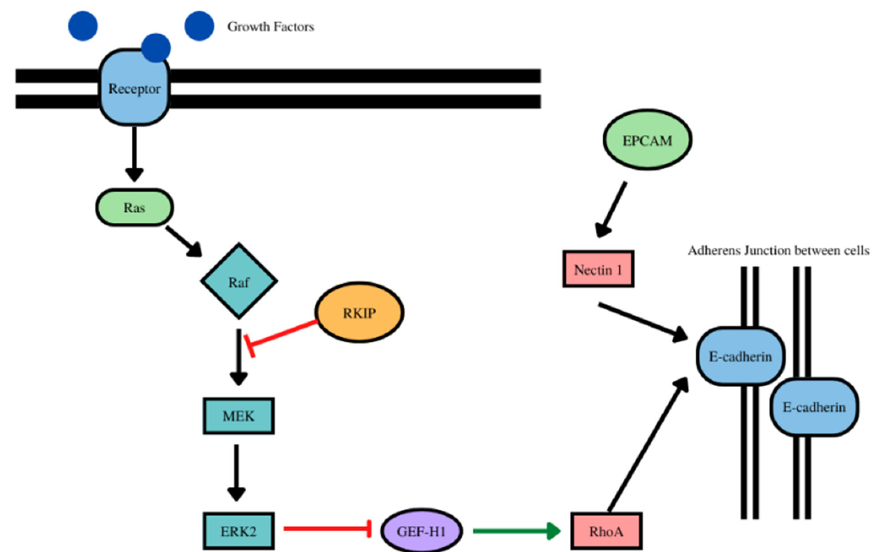
Figure 5. Crosstalk Between RKIP and EPCAM. RKIP inhibits the MEK/ERK signaling pathway by interrupting the interaction between Raf and MEK, stopping the progression of the signal through the pathway. Erk 2 is an inhibitor of GEF-H1, an activator of RhoA which helps in the stabilization of E-cadherin at adherens junctions. EPCAM regulates nectin1 which plays a role in E-cadherins ability to function as an adhesion molecule.